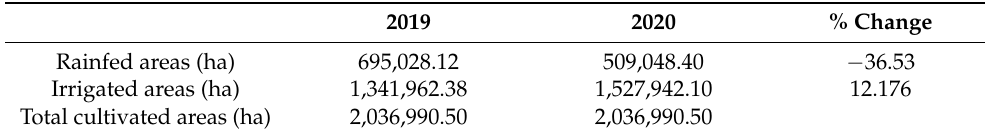
Table 3. Percentage change in the cultivated areas between 2019 and 2020. Negative changes represent a decrease and positive